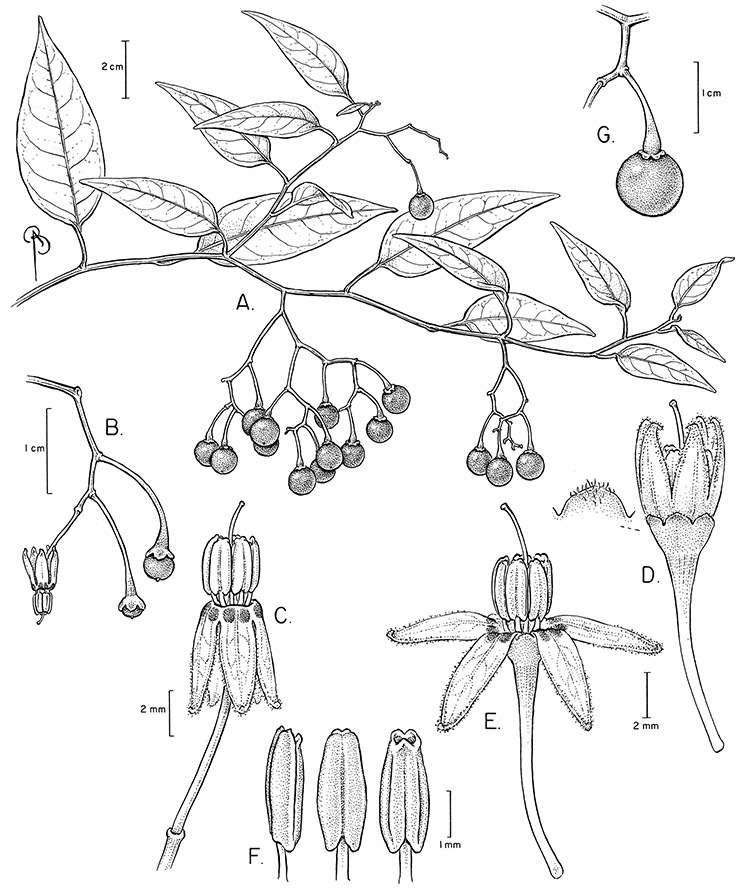
Solanum pittosporifolium Hemsl. (A drawn from Li 96079
B–C drawn from Wan et al. 1824
D–F drawn from Zhou 060
G drawn from photographs of Knapp 10136). Illustration by Bobbi Angell.